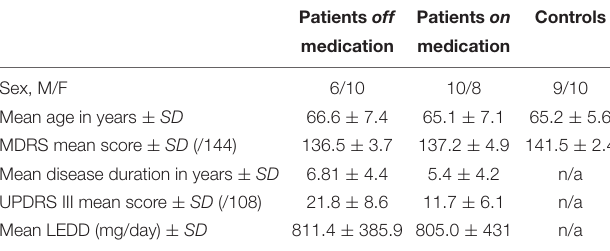
TABLE 1 | Participants’ demographic and clinical data. Patients off Patients on